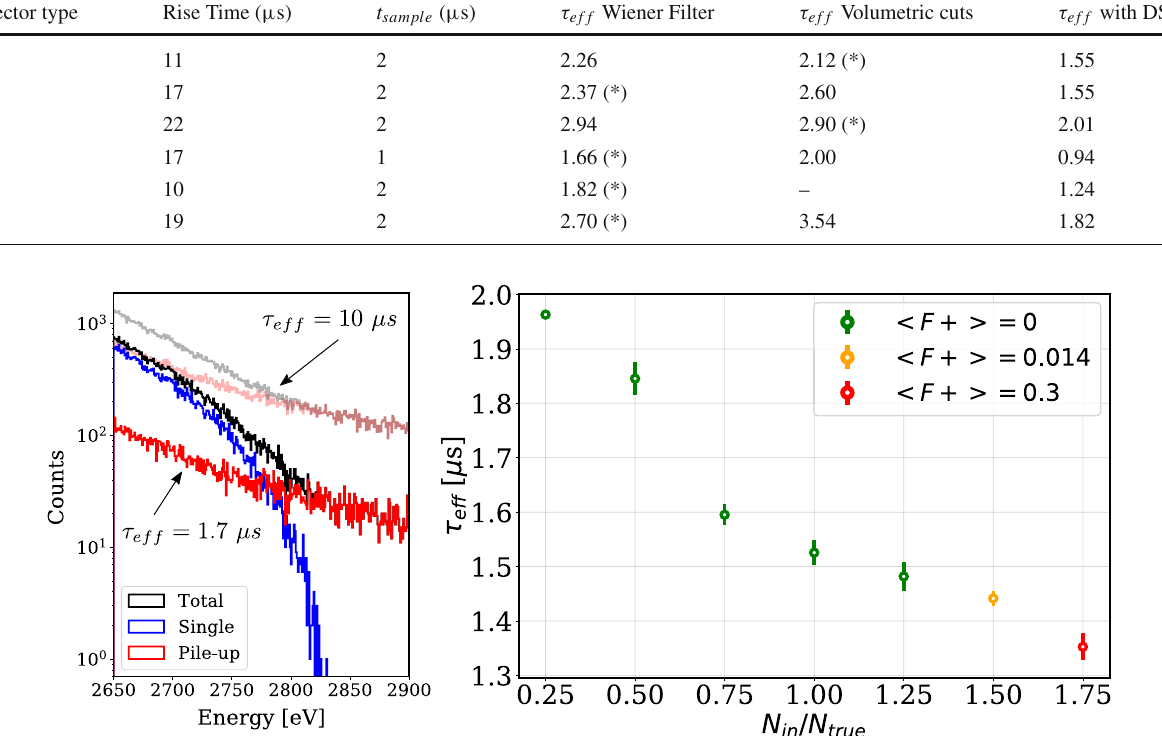
Fig. 6 Left panel: ROI energy spectrum before and after the applica- tion of the WF/Volumetric cuts and the DSVP technique. Light line represents the energy spectrum with τ ef f of 10 µ s, while the solid line with a τ ef f of 1.7 µ s. Right panel: The dependence of τ ef f and the